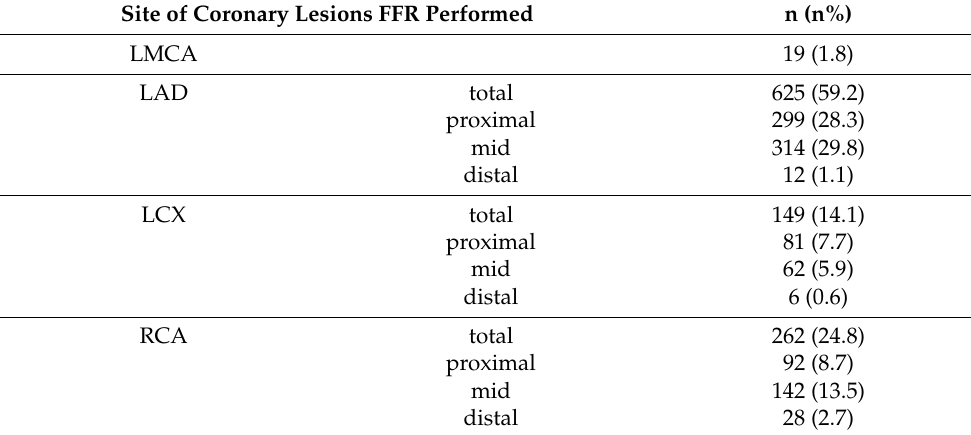
Table 1. Site of coronary stenotic lesions that underwent FFR measurement.